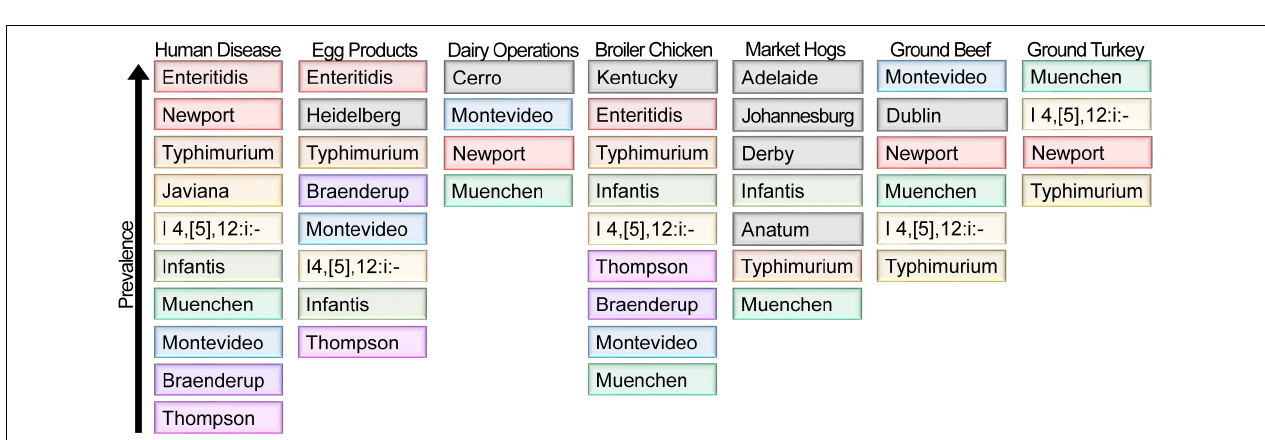
FIGURE 6 | NTS causing overall vs. confirmed outbreak-associated infections in humans. The contribution of select NTS serovars to (A) overall human clinical infections vs. (B) human clinical infections confirmed from a foodborne outbreak are shown as percent infection for a given category. Data are modified from Centers for Disease Control and Prevention [CDC] (2016, 2018).